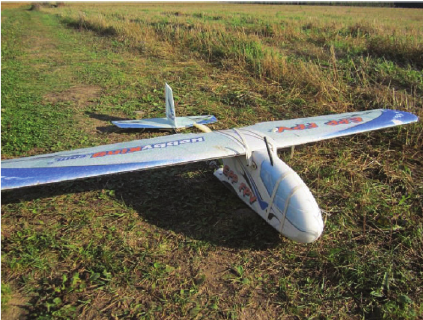
Figure 1: UAV constructed by SSTI and AGAI.